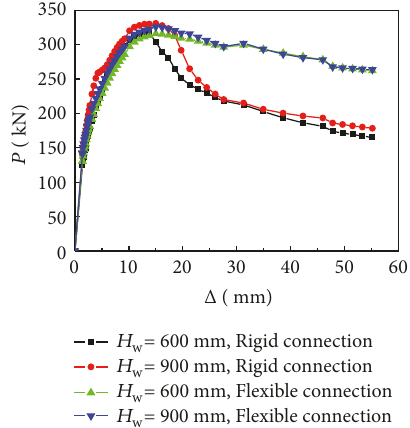
Figure 24: Load-displacement curves of models with different connections.